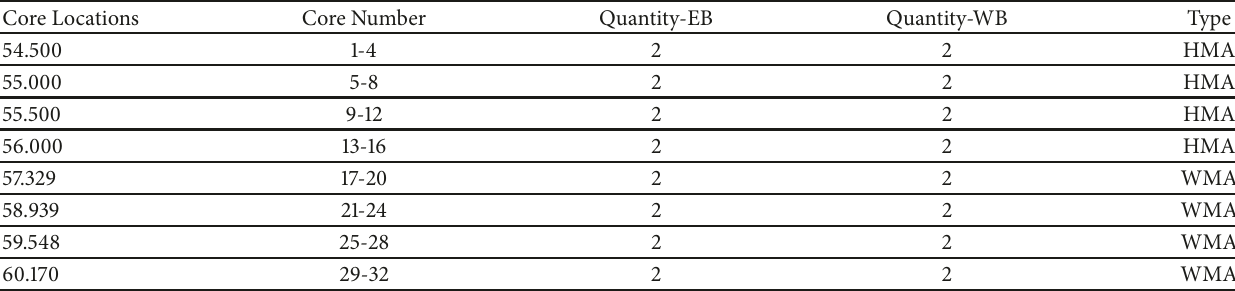
Table 1: Field core specimen identification.